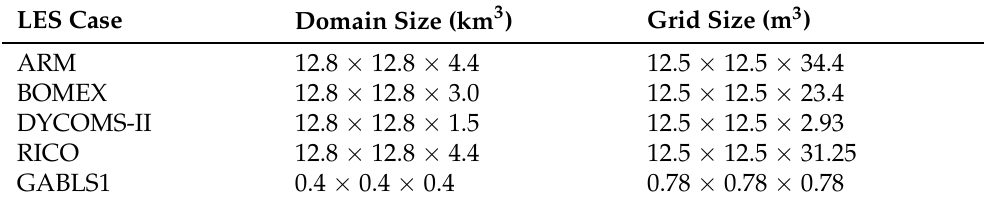
Table 1. Setup of the five idealized case studies run with the MicroHH LES model.